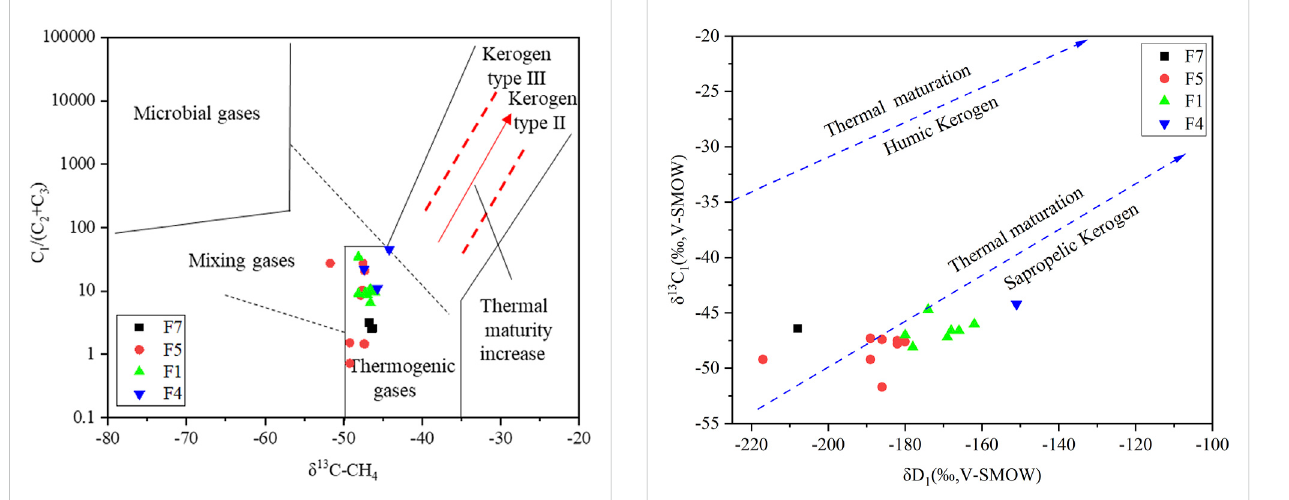
FIGURE 3 Generalized summary plots of δ D − CH 4 vs. δ 13 C − CH 4 for the natural gases from Shunbei area (Modi fi ed from Wang et al.,